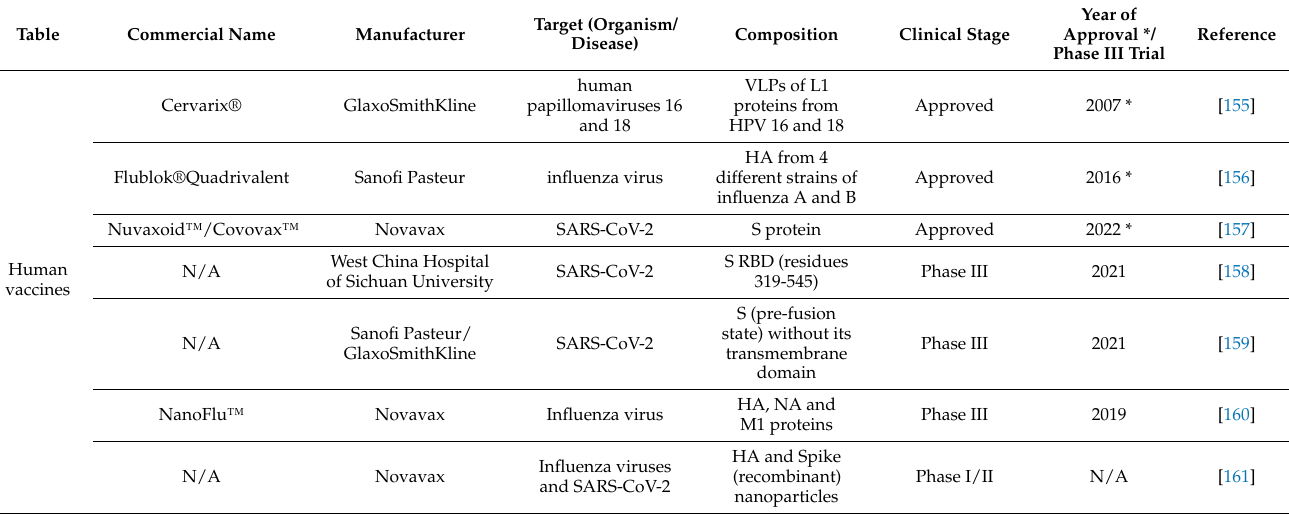
Table 1. BEVS-based health-related products of